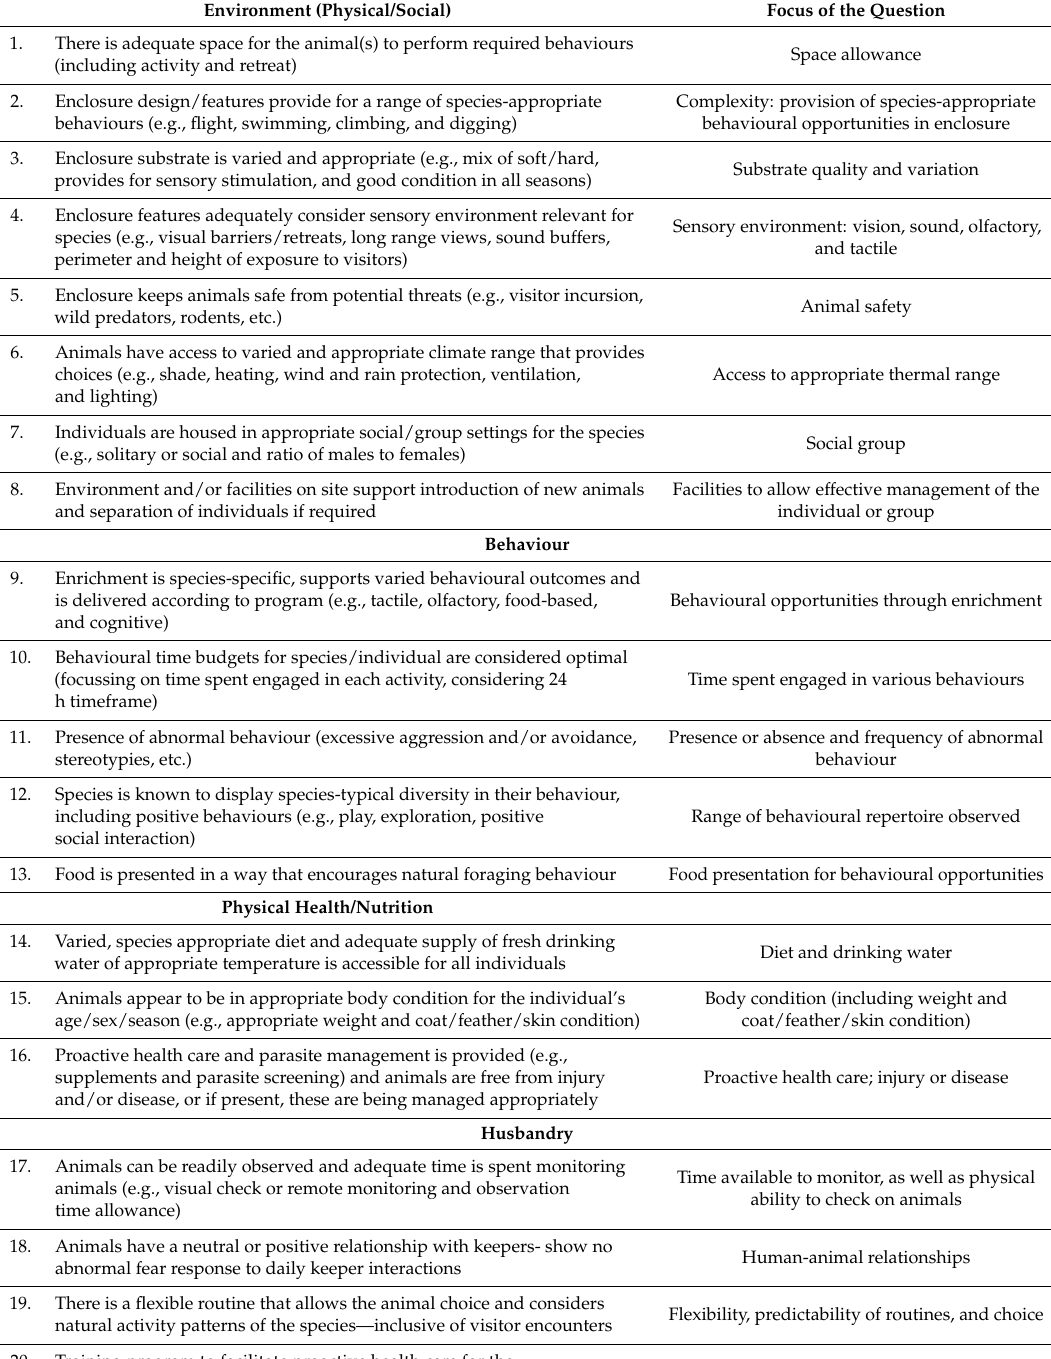
Table 2, using the team’s best understanding of the species’ natural behavioural biology as the gold standard benchmark. These numerical scores were designed to facilitate analysis of what is really a qualitative assessment. Table 1. List of assessment indicators/animal-based measures, categorised across four domains of welfare. The remainder are considered resource-based risk